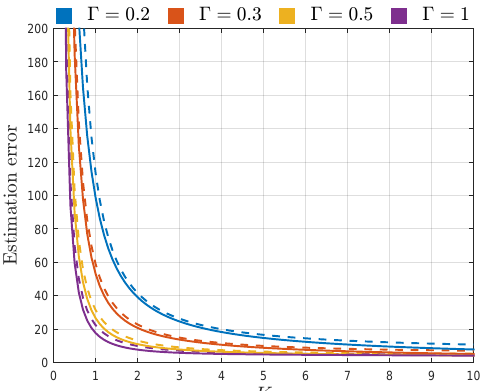
(cid:112) AsV K N / K 2 (dashed line) of ˆ K given by (20), for different